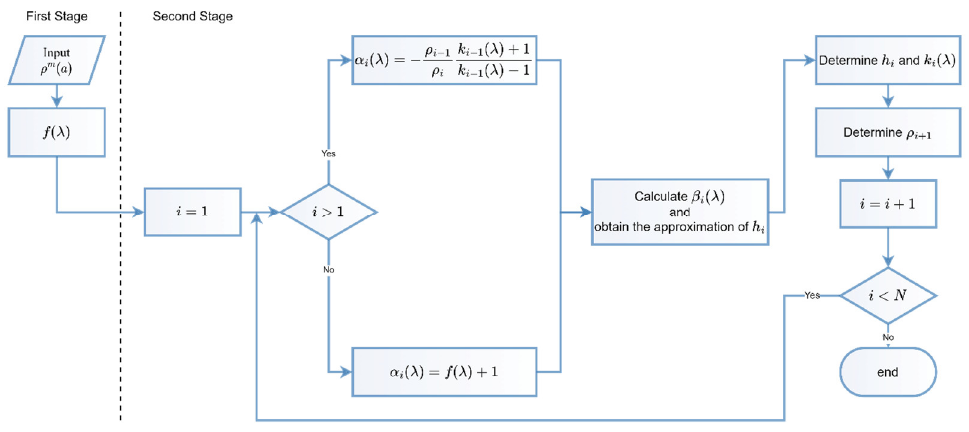
Figure 6. Flow chart for the inversion of soil